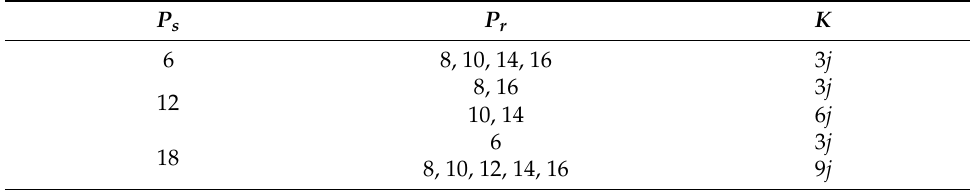
Table 1. Combinations of AM-FRPM